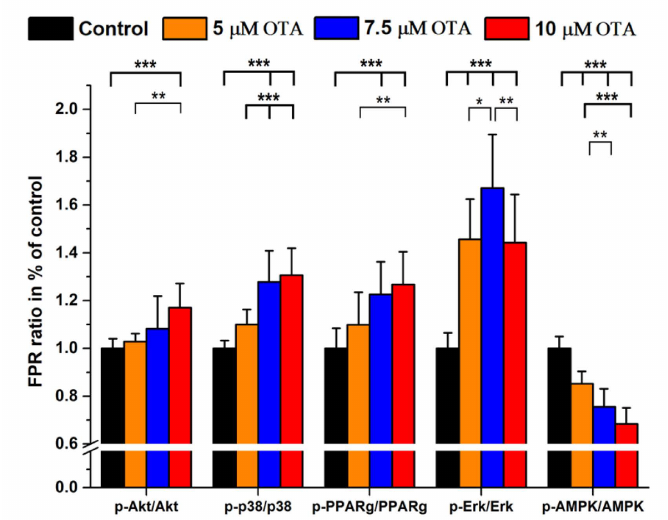
Figure 4. Phosphoprotein/protein expression in OTA (0–10 µ M) treated HepG2 cells shown in FPR % ratios compared with those of controls. (N = 6 × 4). *: p < 0.05, **: p < 0.01, ***: p < 0.001.